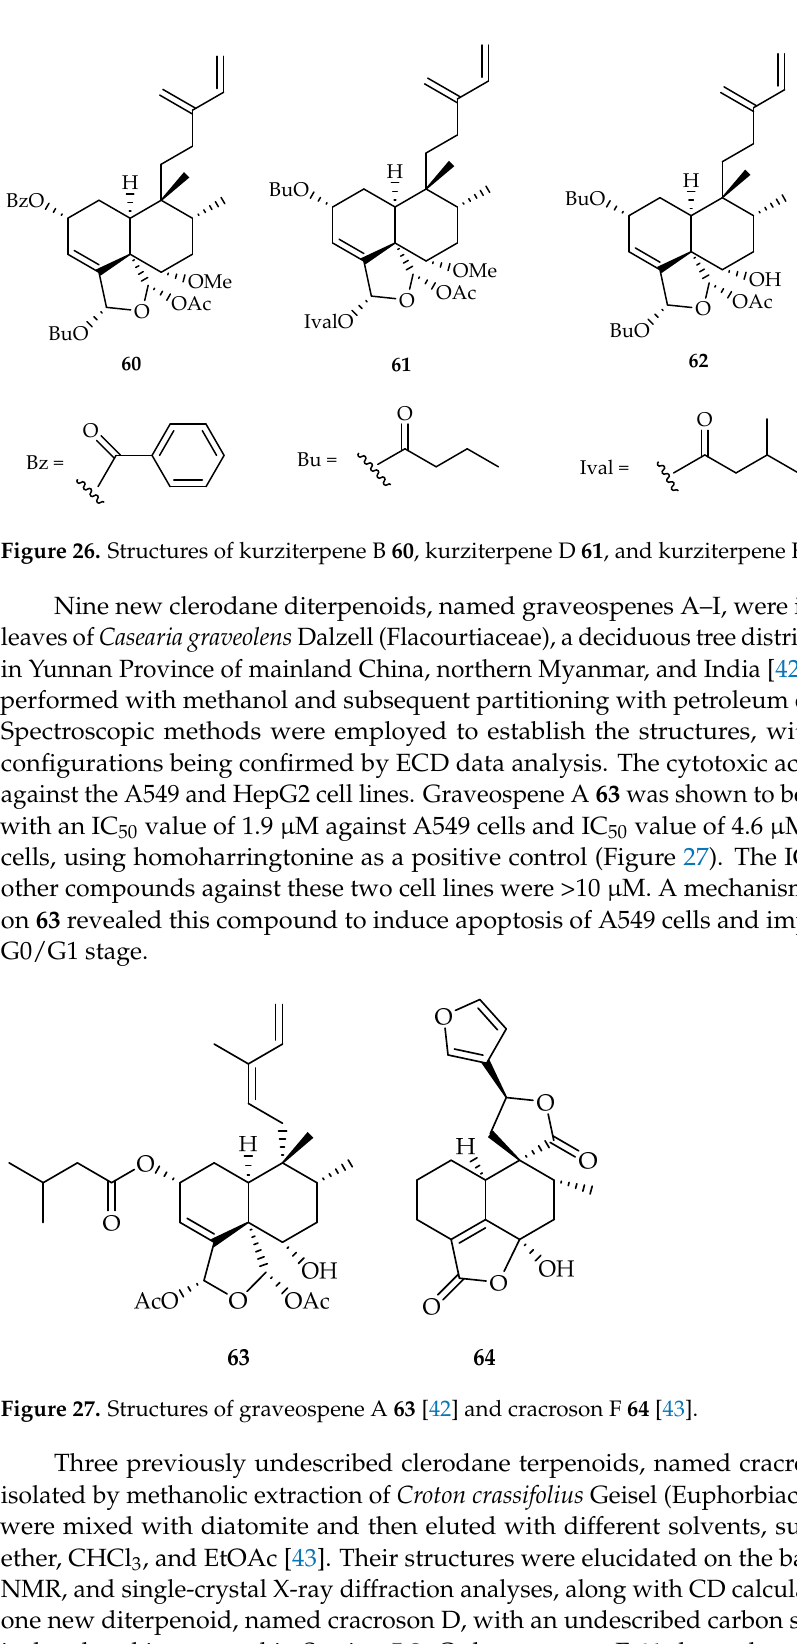
the human HeLa, PANC-1 (human pancreatic), and A549 cell lines. Compounds 65 and isolated and is reported in Section 5.3. Only cracroson F 64 showed an IC 50 value lower